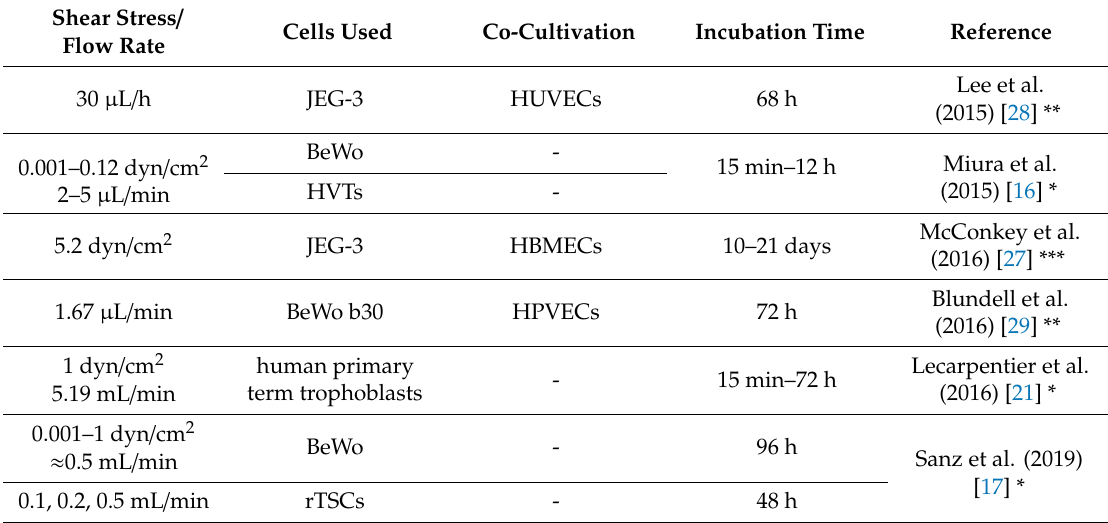
Table 2. Overview of flow culture approaches to study trophoblast di ff erentiation and